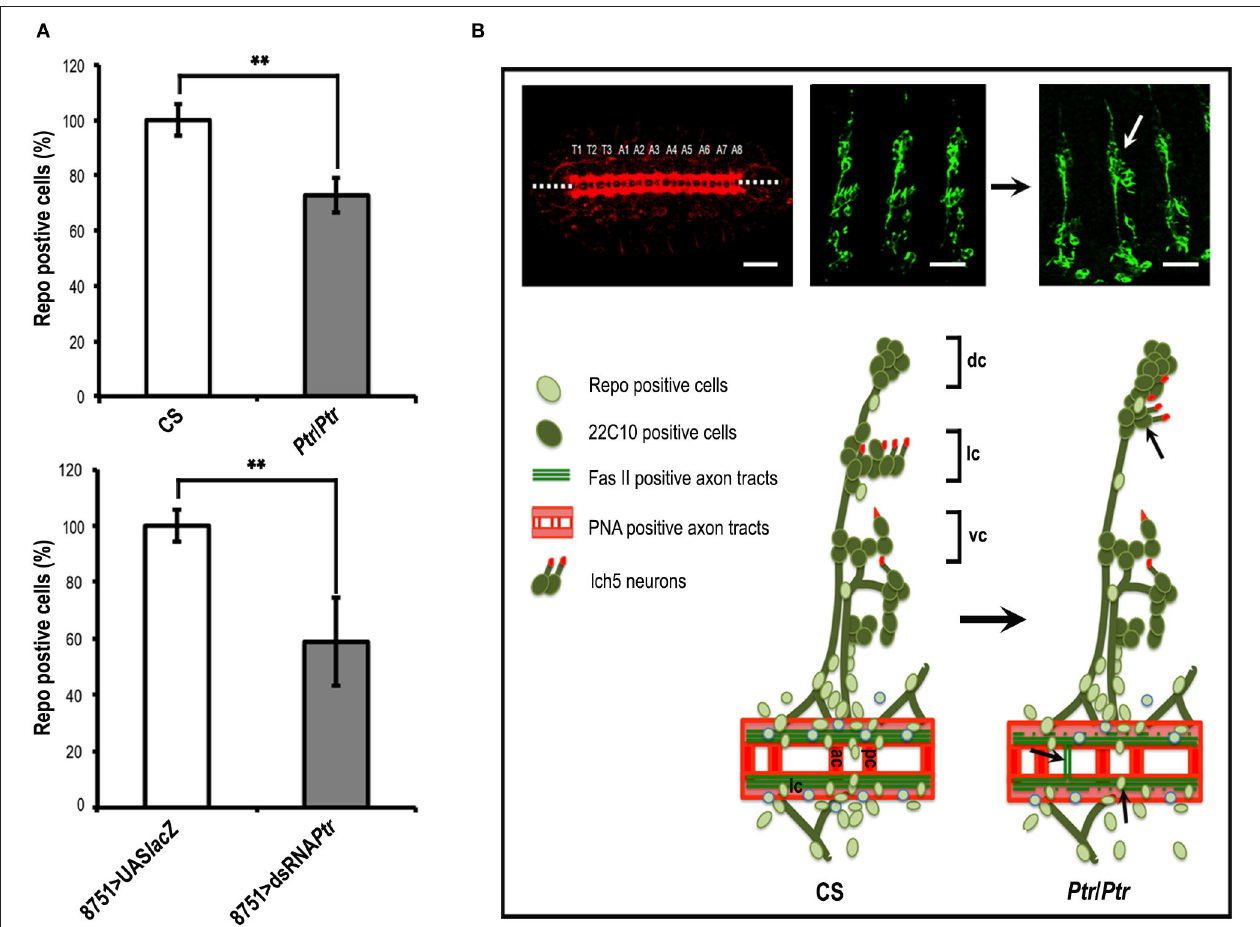
FIGURE 3 | The absence of Ptr produces morphological irregularities at the nervous system level. (A) Quantitative analysis of Repo-positive glial cells in CS and Ptr mutant (the upper graph) and UAS- LacZ and dsRNA Ptr (the bottom graph) embryos at the 15/16 stage. Data represented is the mean ± SEM. (**) indicates p < 0.01. The results showed ∼= 30 and 40% fewer Repo-positive cells in the affected abdominal segments (A2–A6) of mutant and downregulated embryos. (B) Ventral and lateral images of late Drosophila embryos. The left image shows a ventral view of a late embryo stained with PNA lectin that labels CNS axonal tracts. The segmental CNV-repeated pattern is specified as T1–T3 for thoracic segments and A1–A8 for abdominal segments, as in Ivanov et al. (2004). Dotted lines indicate the embryo midline. Middle and right images show lateral views of CS and Ptr null mutant late embryos stained with 22C10 to visualize neuronal morphology and axonal projections. The white arrow indicates an evident lch5 neuronal miss-migration. The lower illustrations schematize the main PNS characteristics detected when comparing CS and Ptr null mutant embryos. Black arrows indicate the miss-migration of neurons, axon midline crossovers, and reduction of Repo-positive glia. Abbreviations in CNS: ac, anterior commissure; pc, posterior commissure; lc, longitudinal connectives. Abbreviations in PNS: dorsal (dc), lateral (lc) and ventral (vc) clusters, respectively. Bars: 50 and 75 µ m for PNA and 22C10 staining,